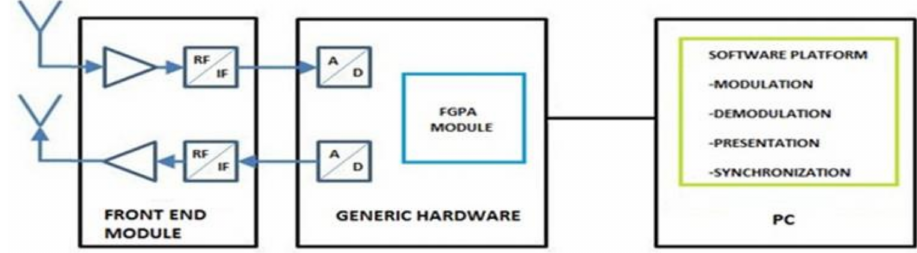
Figure 4. A generic hardware configuration of